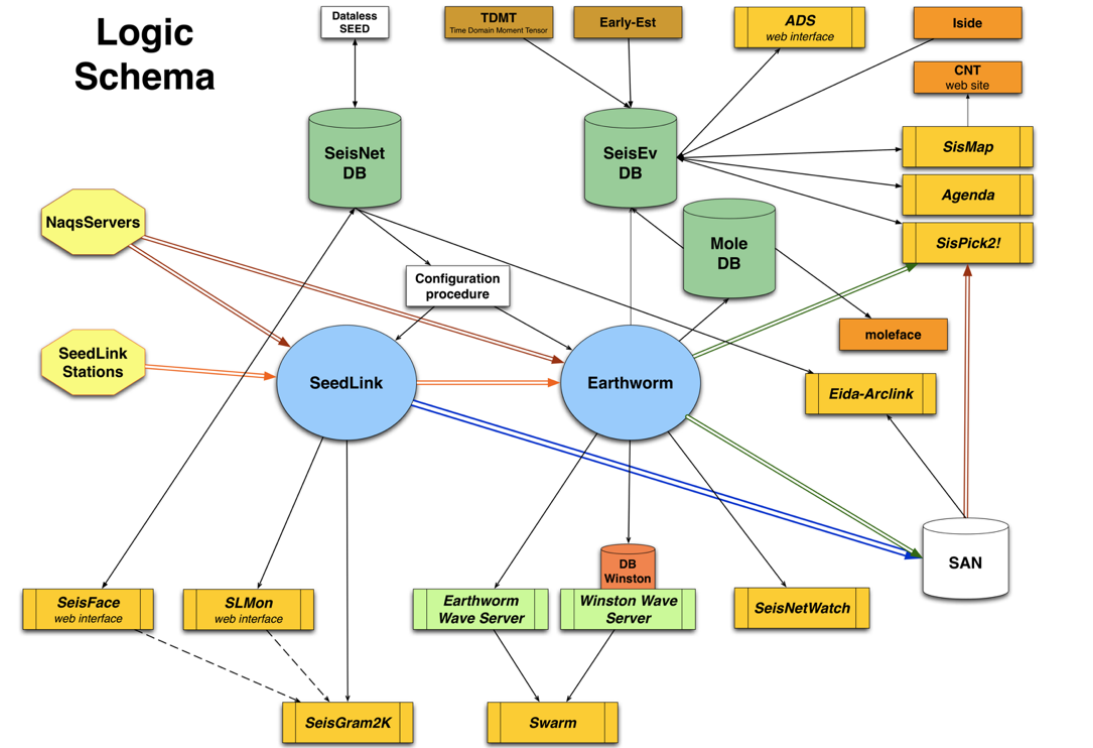
Figure 1. Scheme of the AIDA system demonstrating the data flow from stations (SeedLink and Nanometrics protocols) to real-time analysis and archiv- ing. ADS, Seismic Data Analysis; CNT, National Earthquake Center; DB, database; SAN, Storage Area Network; TDMT, time-domain moment tensors.